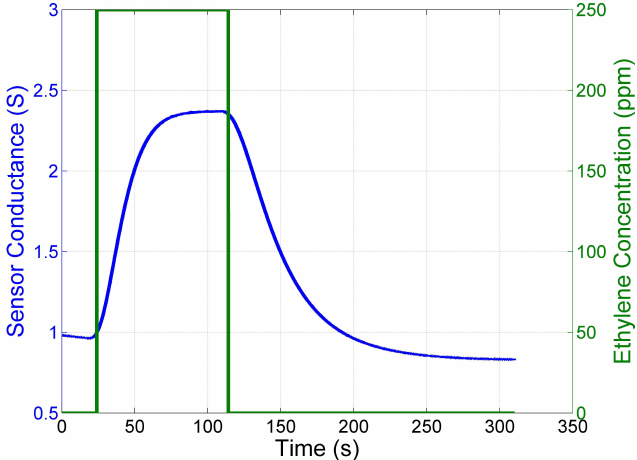
Figure 1. Response of a Figaro TGS2600 to a pulse of 250 ppm of Ethylene obtained in a closed sampling system.